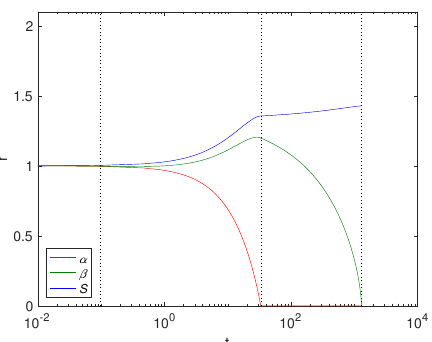
Figure 2. Plots of the dimensionsionless variables α , β and S against t in cylindrical geometry using ε 1 = 0.6, ε 2 = 0.4, κ = 0.04, the parameters in Table 4 and S 0 = 1. The dashed lines show t = T α = β ( left ), t = T α ( middle ) and T β ( right ).